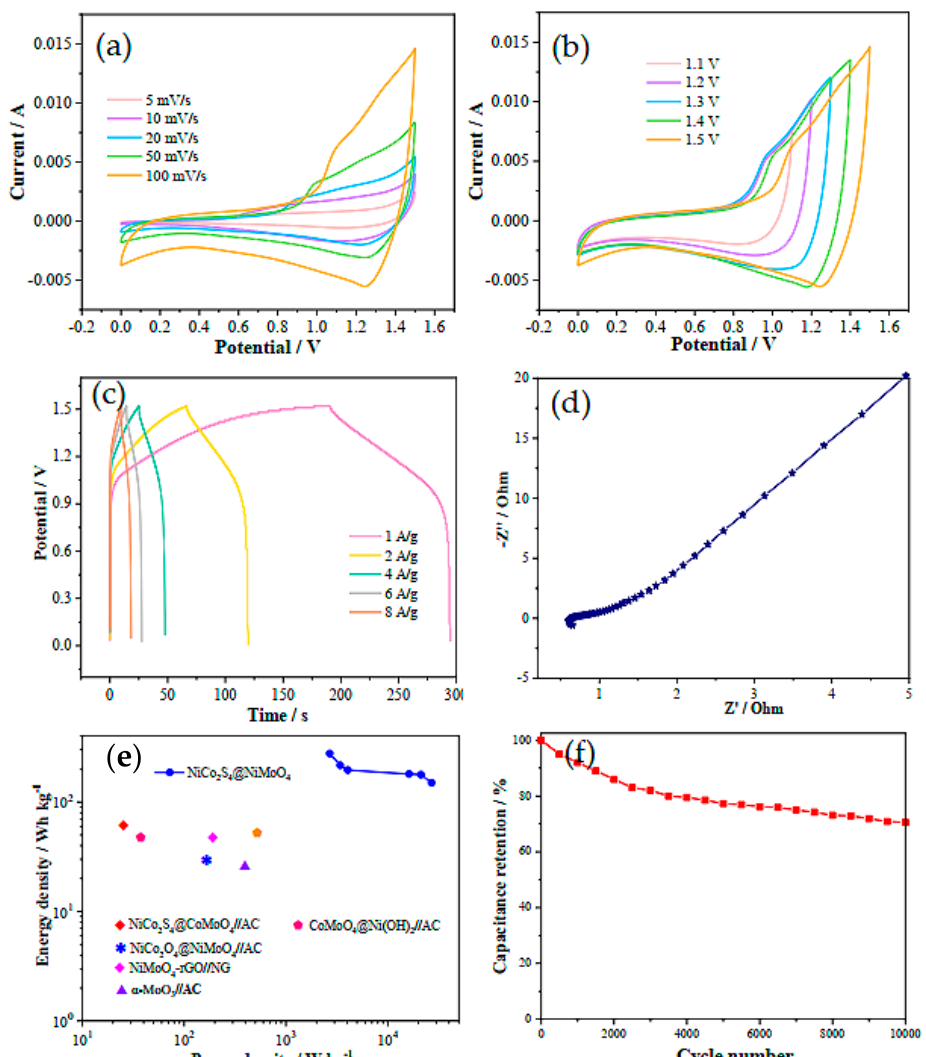
Figure 6. ( a ) CV curves, ( b ) CV curves at different potential, ( c ) GCD curves, ( d ) electrochemical impedance spectroscopy, ( e ) Ragone plot, ( f ) cycle stability.